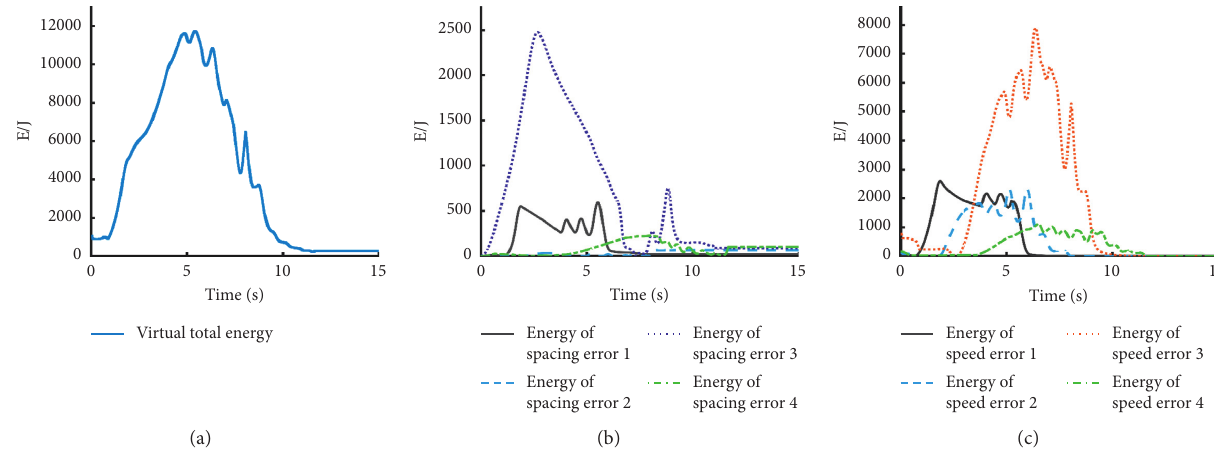
Figure 12: Energy accumulation of the mixed platoon. (a) Total energy accumulation. (b) Energy generated by spacing errors. (c) Energy generated by speed